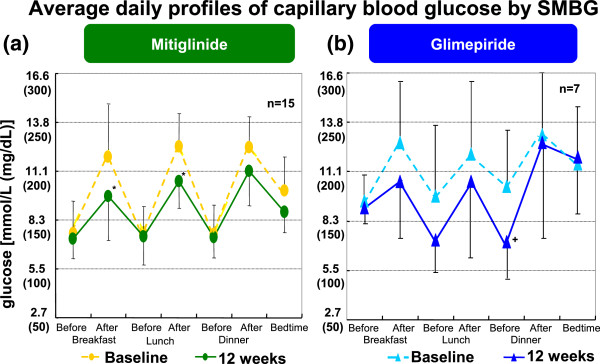
Average daily profiles of capillary blood glucose by SMBG. Postprandial glucose level was significantly improved by mitiglinide at all mealtimes (a). In contrast, glimepiride reduced both pre- and post-prandial glucose level, and there was significant reduction of blood glucose level in before dinner time (b).